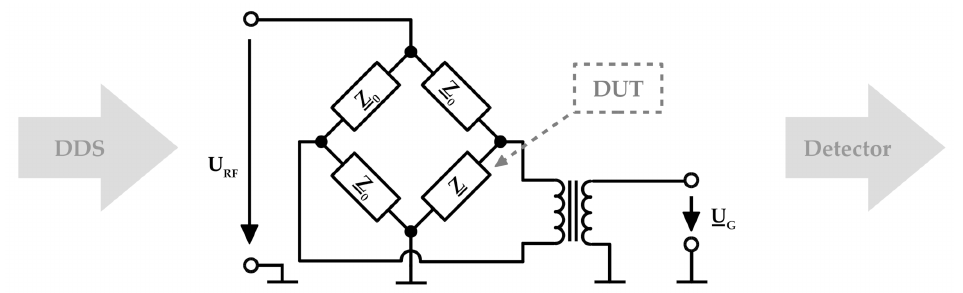
Figure 9. Wheatstone bridge circuit for complex impedance